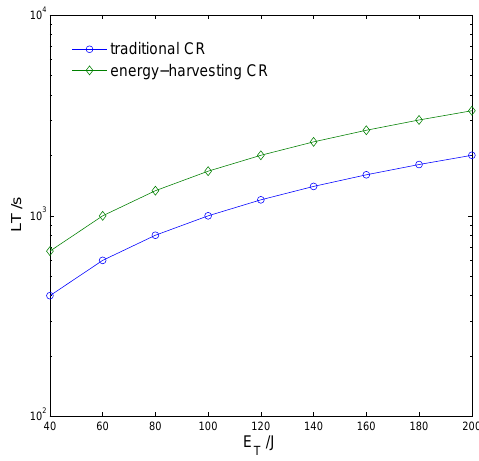
Figure 11. Lifetime comparison of different cognitive radio (CR)